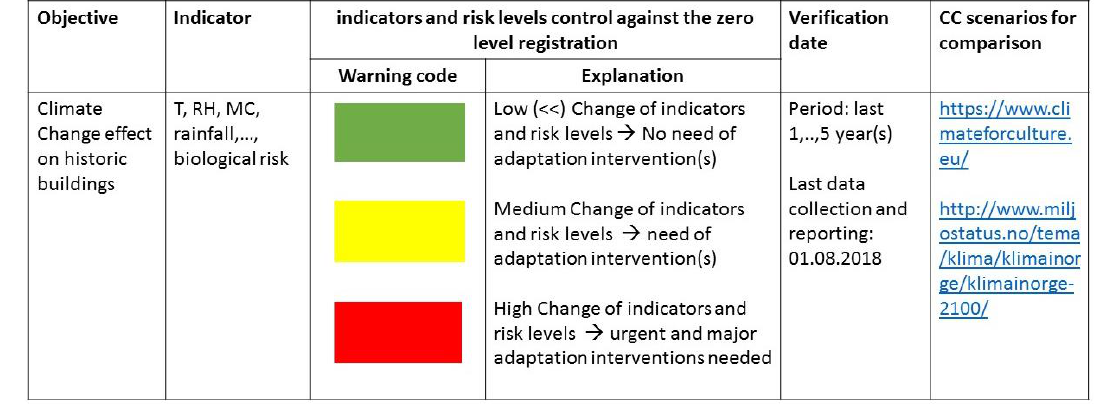
Figure 7. Setup of the indicators used in the long-term monitoring program to assess the impact of climate change on historic buildings.